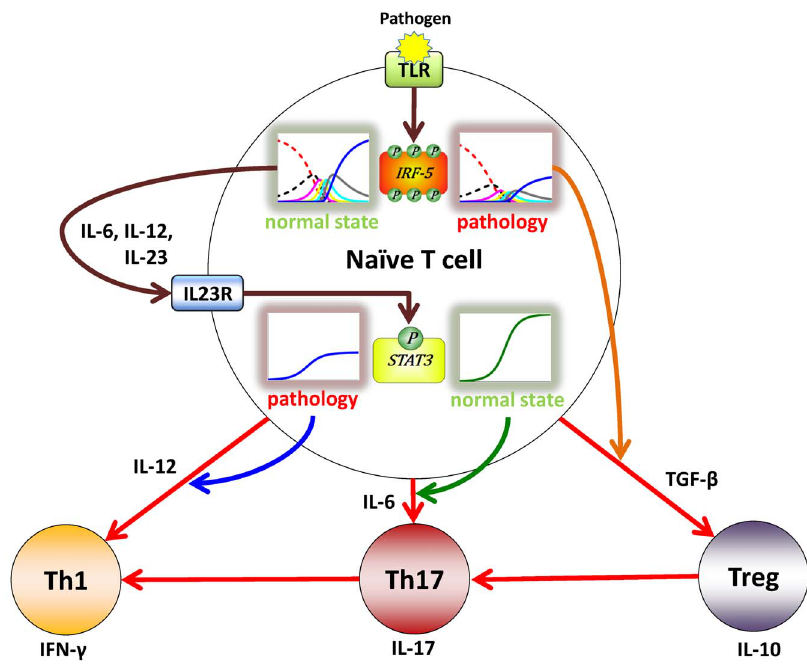
Figure 1. A schematic diagram for the dependence of T cell differentiation on intracellular phosphorylation signaling. A vast amount of experimental evidence suggests that T cell phenotypes strongly depend on the intracellular phosphorylation signaling mechanisms [44–50]. Environmental factors, genetic mutations, cellular and intracellular factors influence the underlying phosphorylation mechanics. The cartoon summarizes possible differential responses of TLR downstream phosphorylation signaling events to pathogens leading to the distinct polarization of naive T cells into three distinct phenotypes Th17, Th1 and Treg. According to this model activation or interplay of phosphorylation pathways is responsible for selective differentiation as well as for T cell phenotype switching. The model suggests that the cell plasticity observed under pathological conditions can be due to altered intracellular phosphorylation patterns, which are, in turn, dependent on the extracellular cytokine